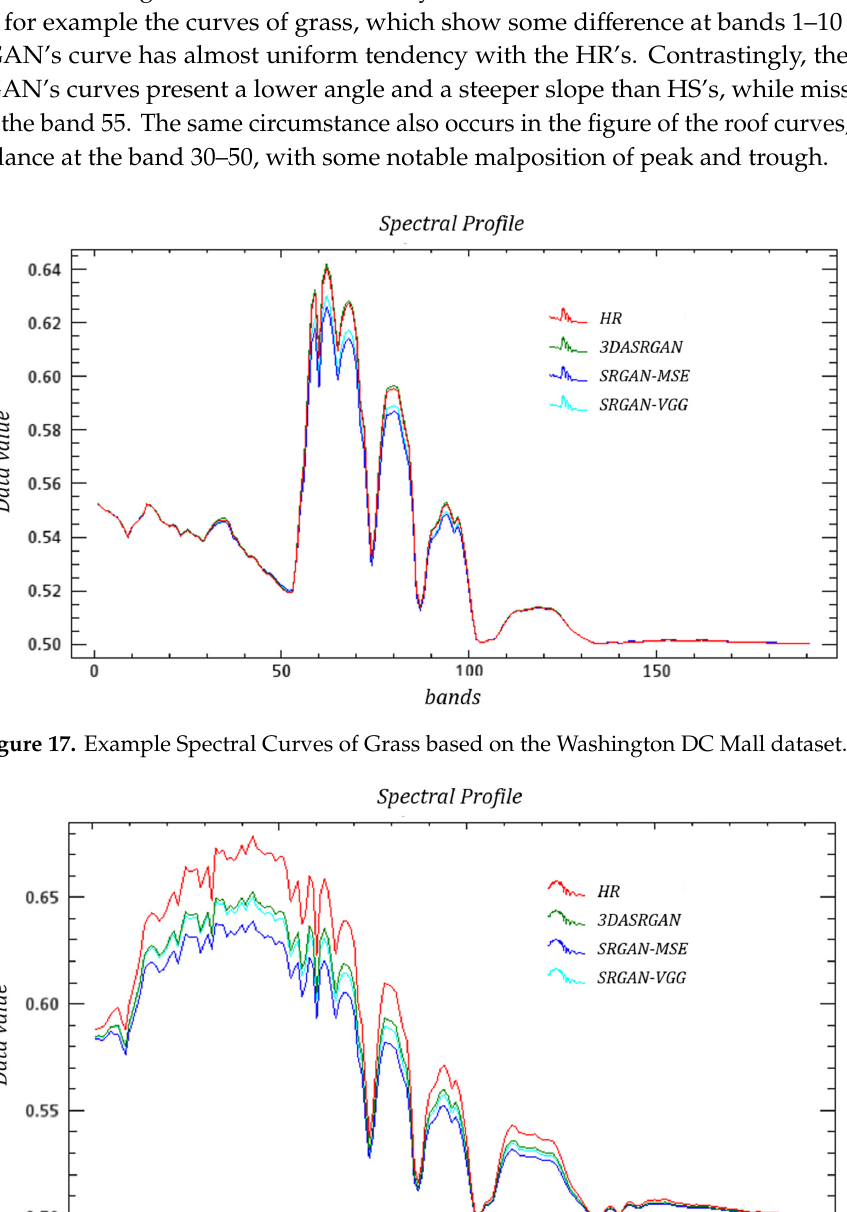
Table 3. Quantitative comparison results of 3DASRGAN and SRGAN based on the Washington DC Mall dataset.